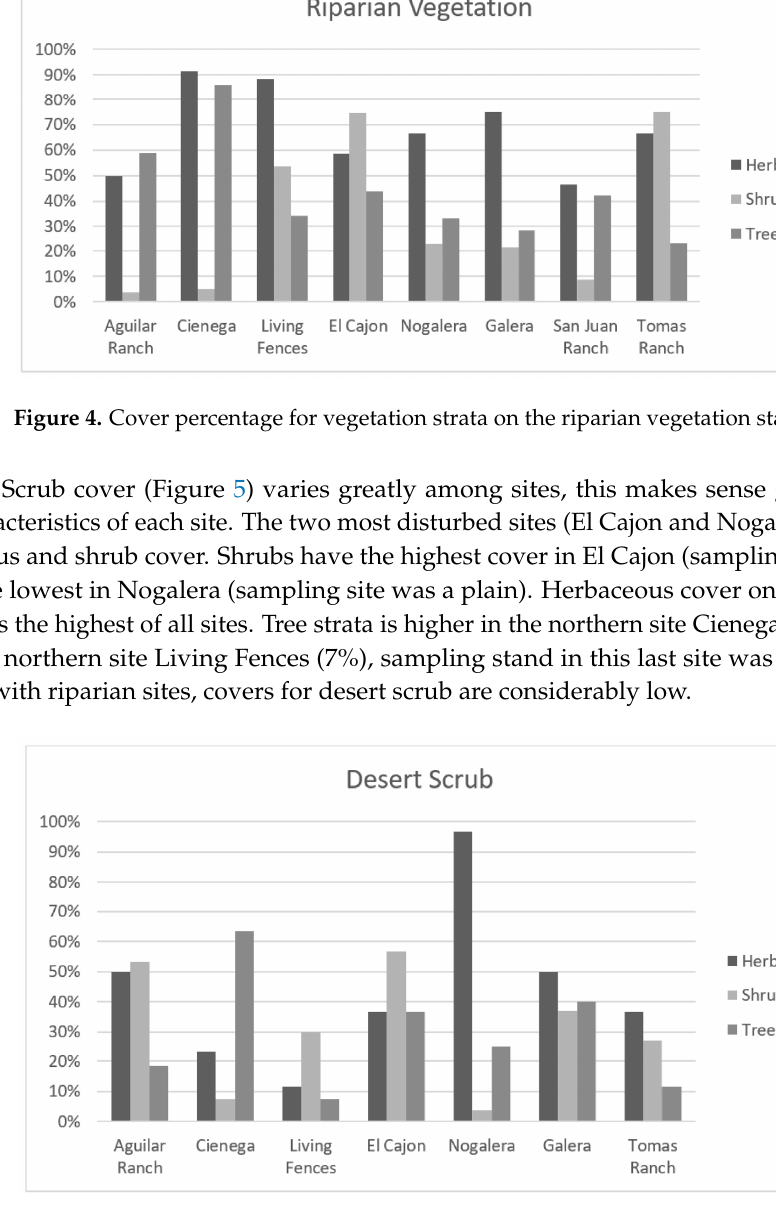
Figure 5. Cover percentage for vegetation strata on the desert scrub stands.